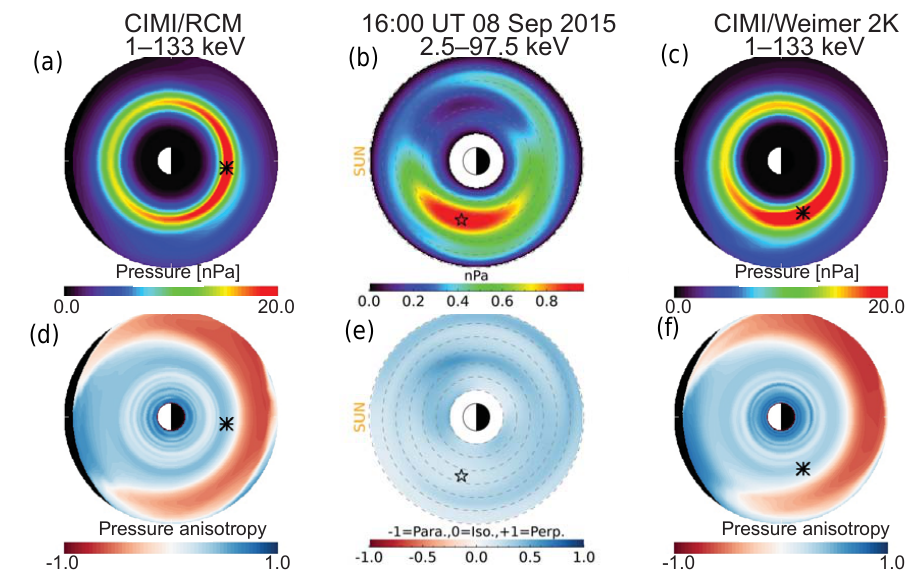
Figure 5. The ion equatorial pressure and pressure anisotropy for 16:00UT 8 September 2015 in the same format as Fig. 3.